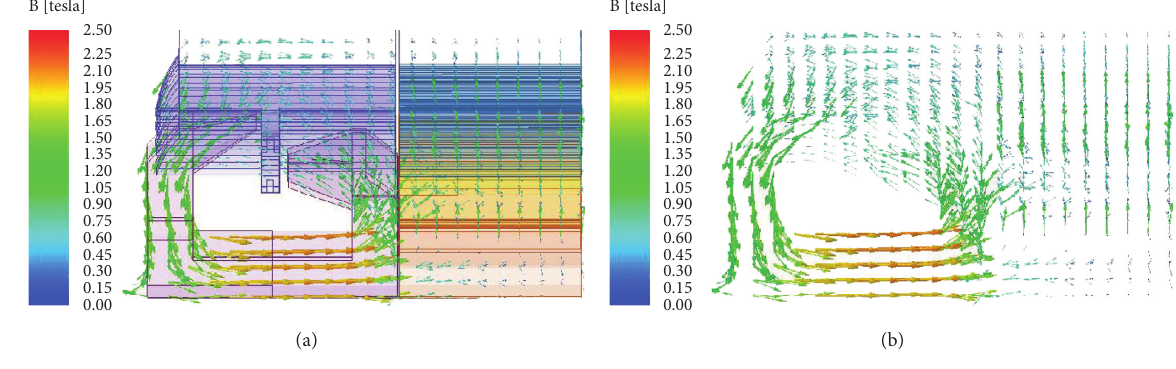
Figure 13: Magnetic flux vector on the axial observation surface.